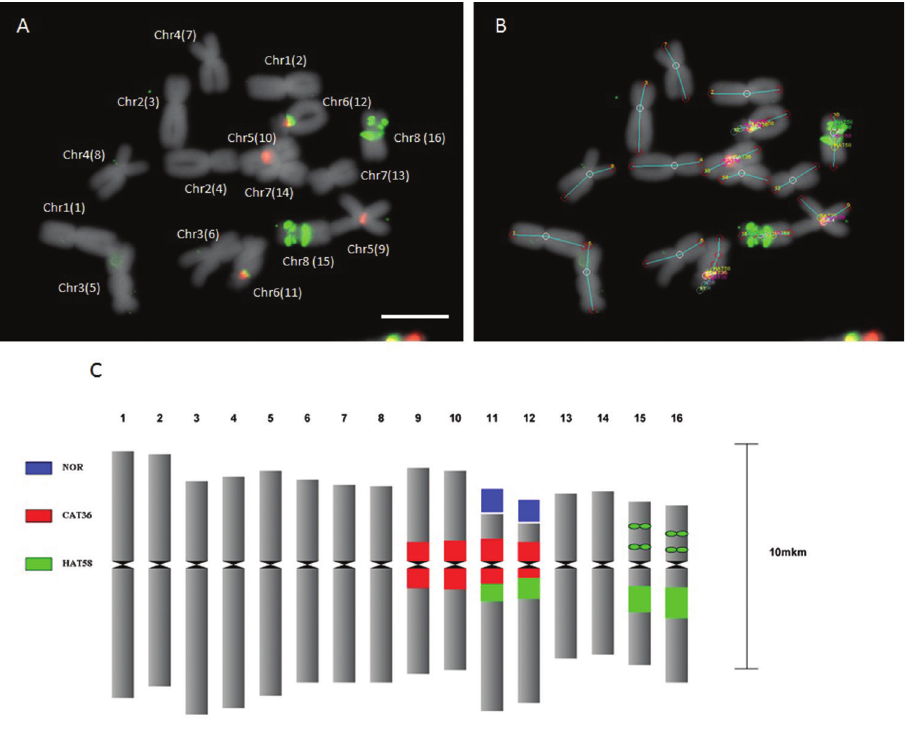
Figure 3. A Metaphase chromosomes of A. fistulosum after FISH with HAT58 (green signal) and CAT36 (red signals) repeats. Numbers in brackets correspond to the numbers on the idiogram ( C ) B The same picture as in A but after measurements by DRAWID C Idiogram obtained from the measurements in A and B Scale bar – 10